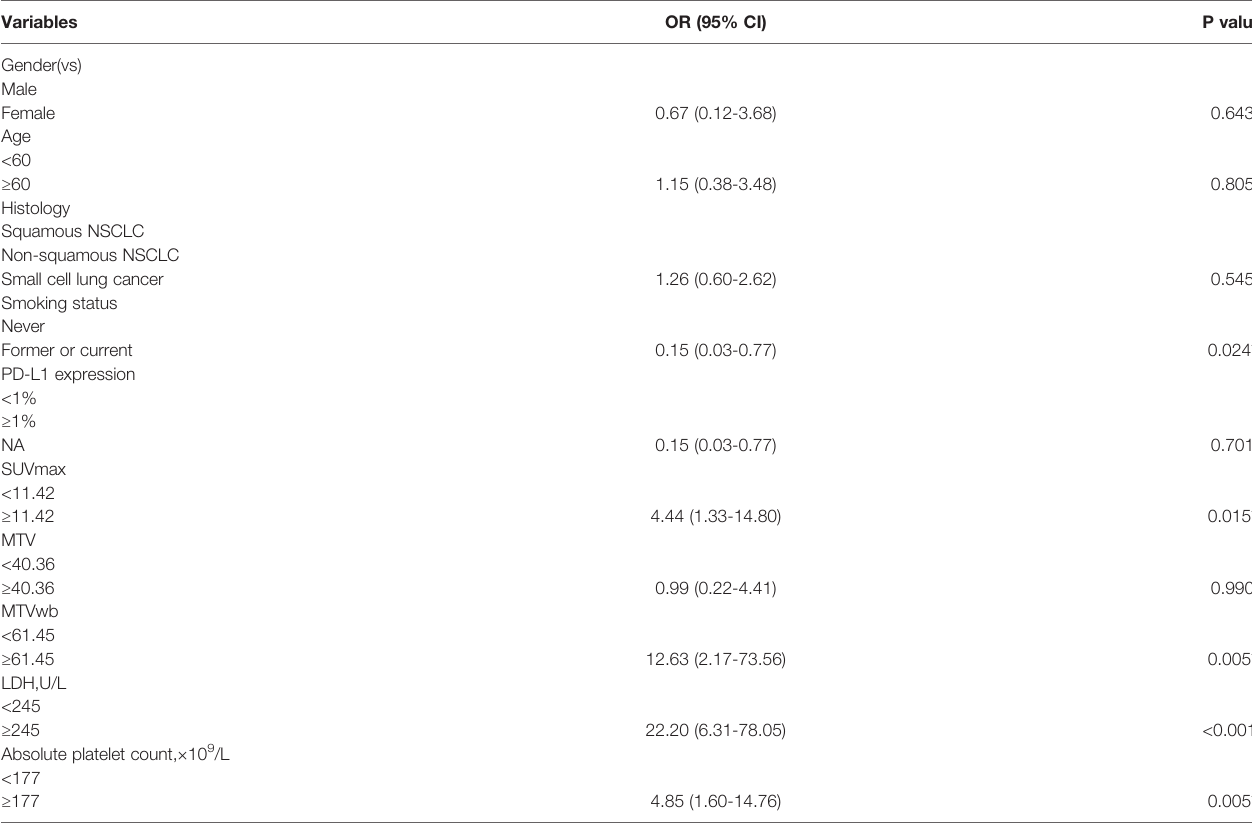
TABLE 3 | Logistic regression of clinical bene fi t in 120 patients.